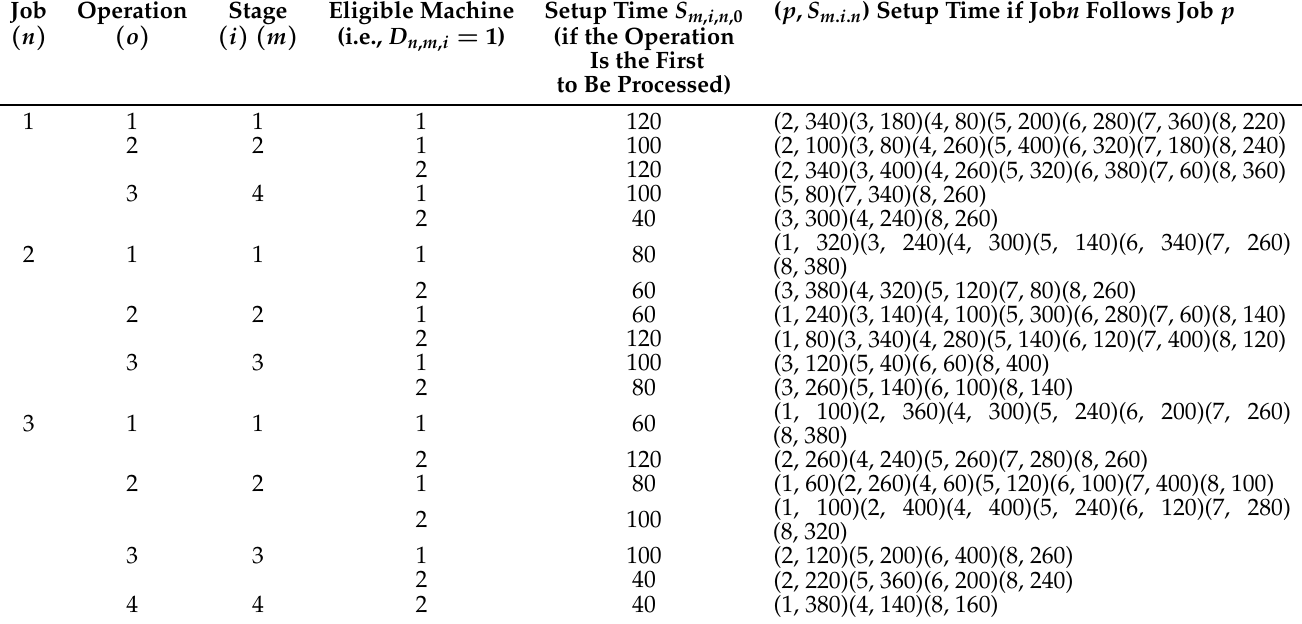
Table 5. Setup time for each eligible machine for each